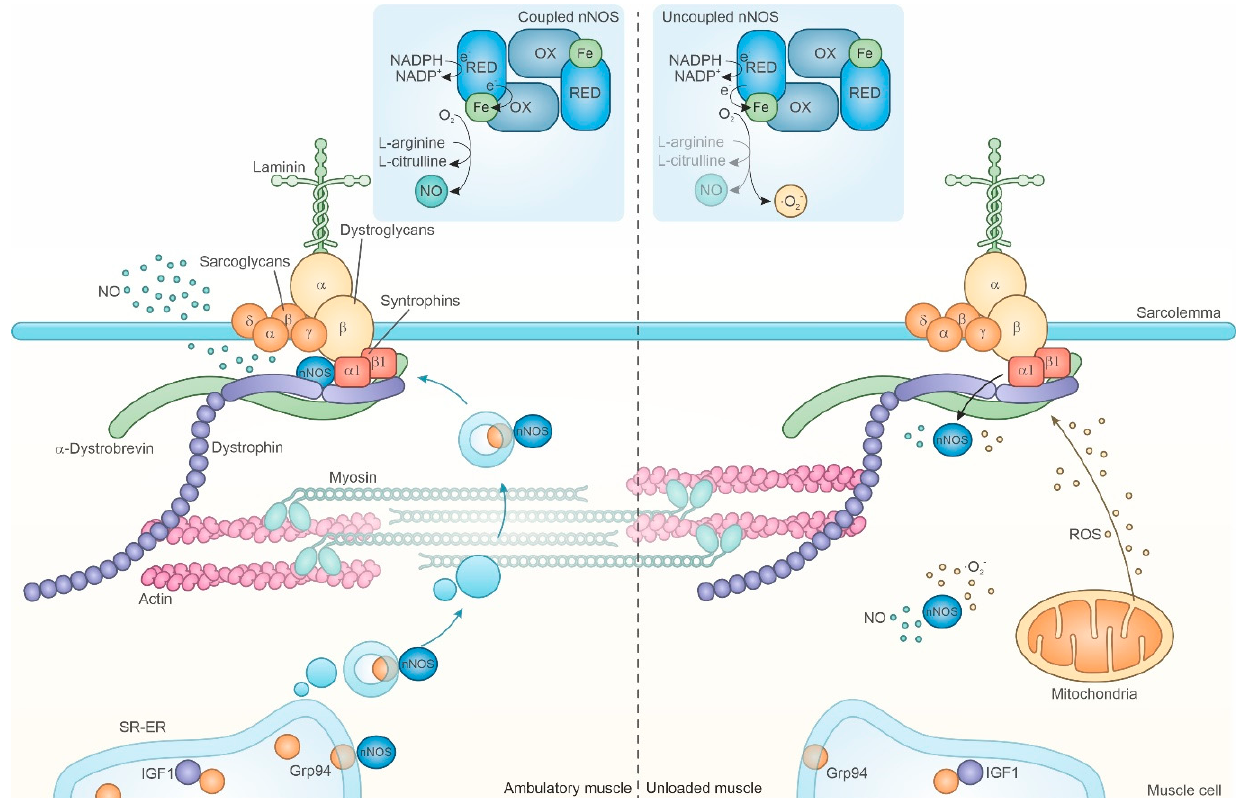
Figure 1. The neuronal NOS µ isoform interacts with the Grp94/gp96 chaperone and is delivered at the subsarcolemma by docking at the DCG. Unloading-induced mitochondrial ROS production causes nNOS µ untethering from DGC and translocation in the sarcoplasm, where the enzyme through either “coupled” or “uncoupled” NADPH oxidation (inset) leads to NO/O 2 − production, respectively, and FoxO3 activation. NO = nitric oxide; nNOS = neuronal nitric oxide synthase; SR-ER = sarco-endoplasmic reticulum; IGF1 = insulin-like growth factor